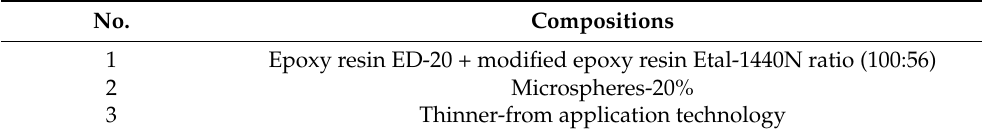
Table 6. Recommended compositions.